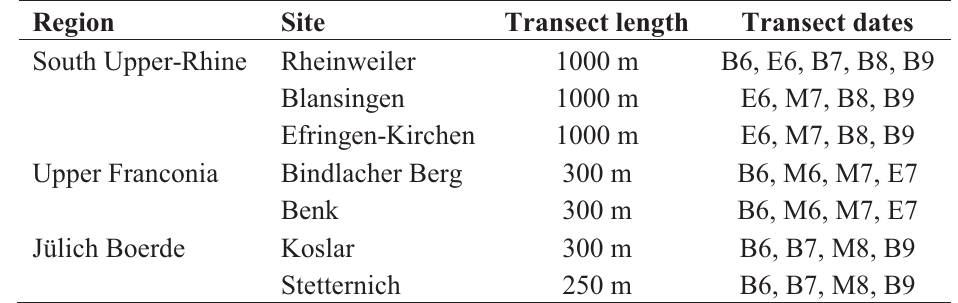
Table 1. Transect counts in the three study regions in 2008 . Figures of “Transect dates” refer to the month of recording, and B = Beginning, M = Mid, E = End.